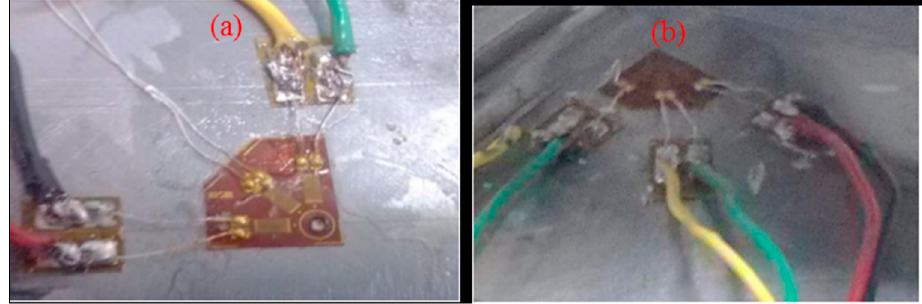
Figure 4. Connection modes of strain gauge lead in longitudinal and transverse directions ( a ) and removal of strain gauge lead ( b ).